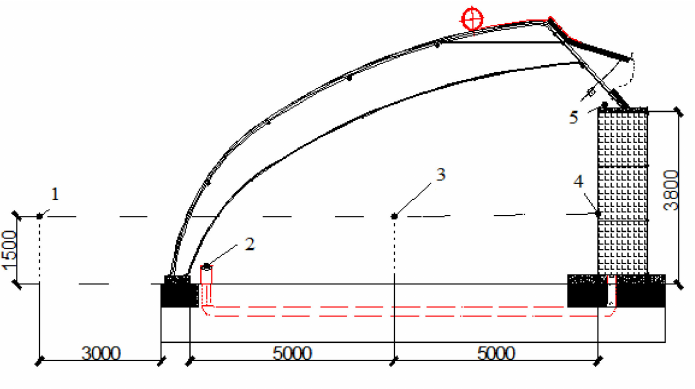
Figure 4. Layout of measuring